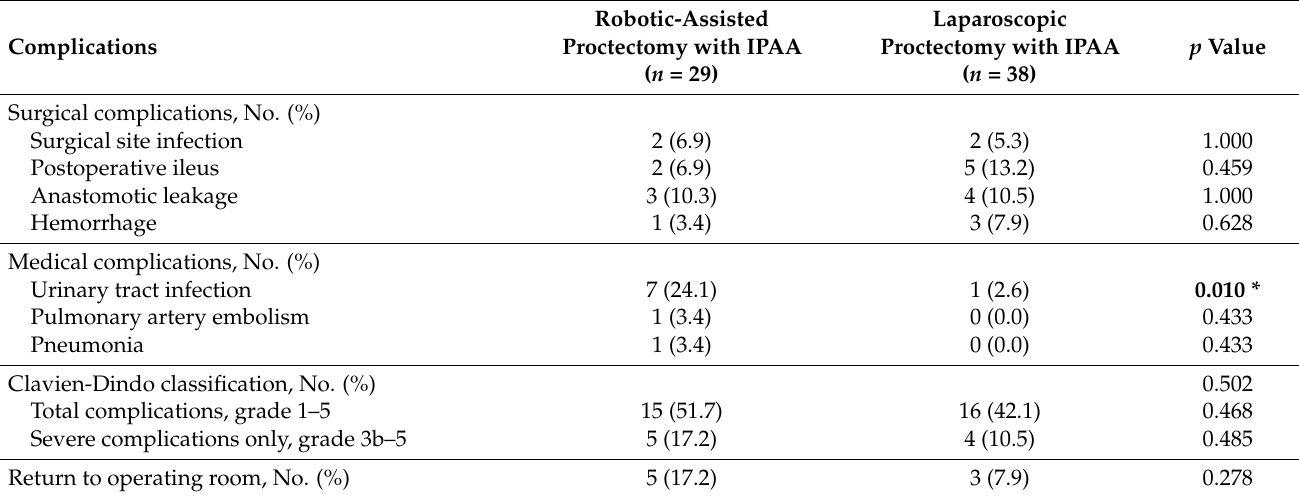
Table 2. Postoperative Complications within 30